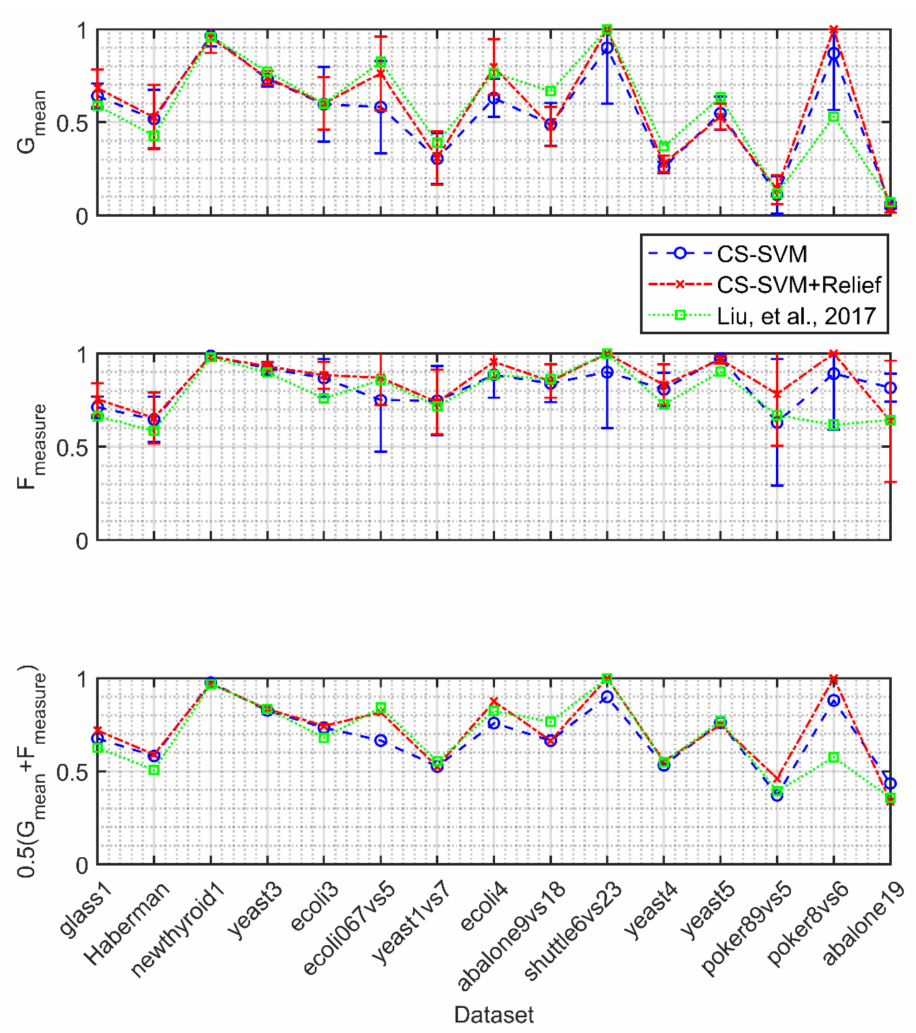
Figure 4. Comparison between the classification performances of the three methods: CS-SVM, CS-SVM + Relief and Liu et al.’s method